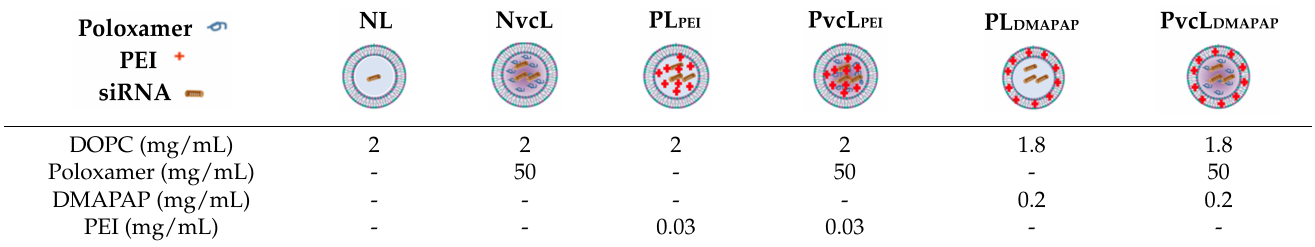
Table 1. Graphical representation of tested formulations and their composition. The siRNA concentration was 30 nM for all the formulations